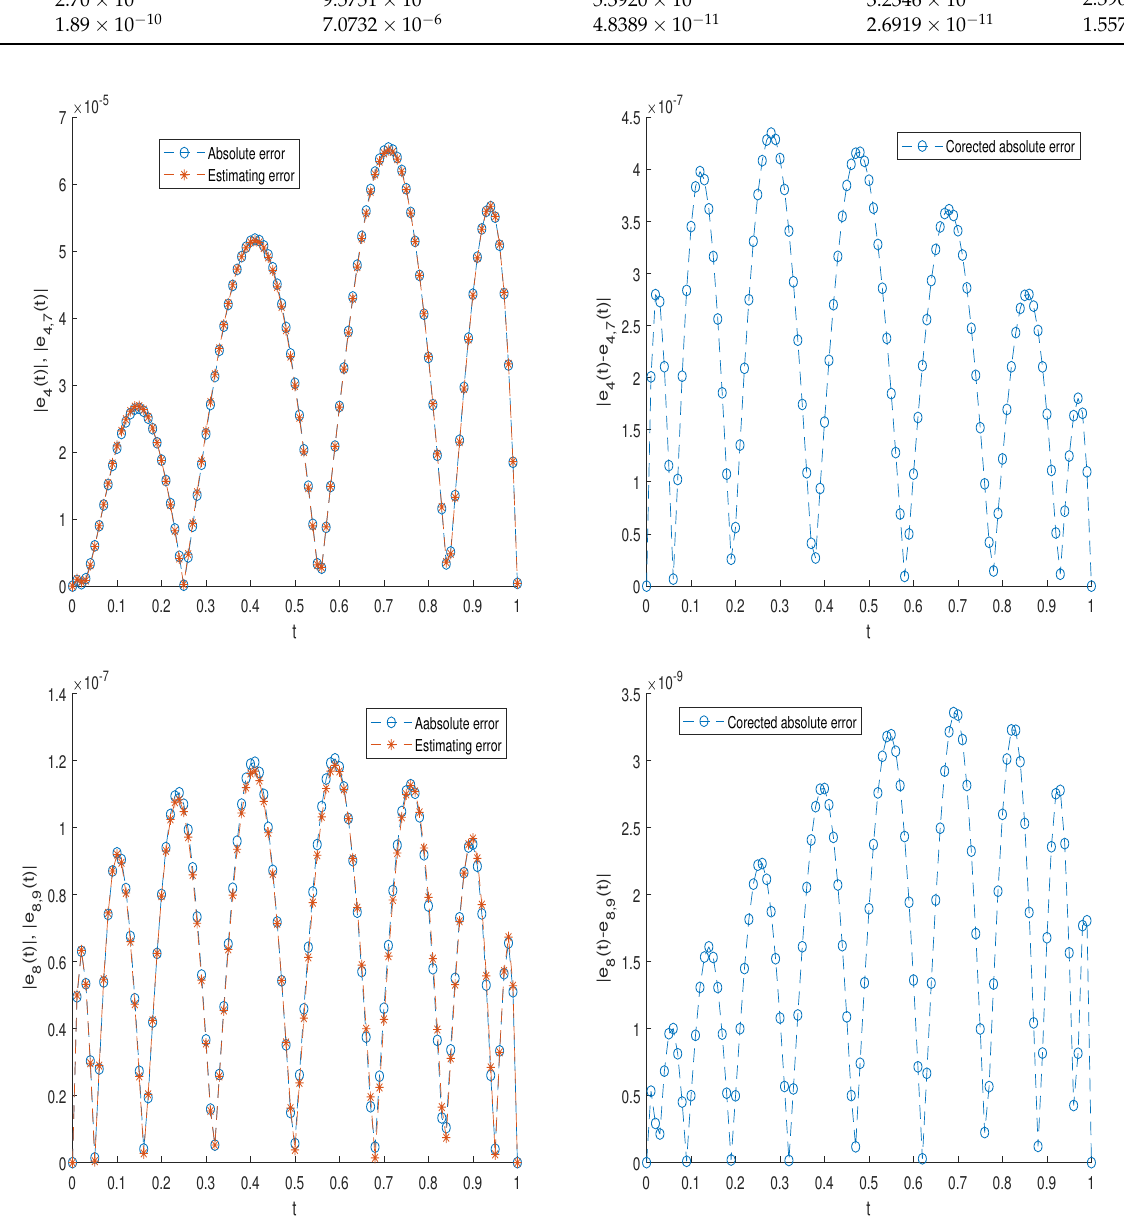
Figure 3. The absolute error e 4 with its estimation e 4,7 ; e 8 with its estimation e 8,9 ; and the corrected errors for Example